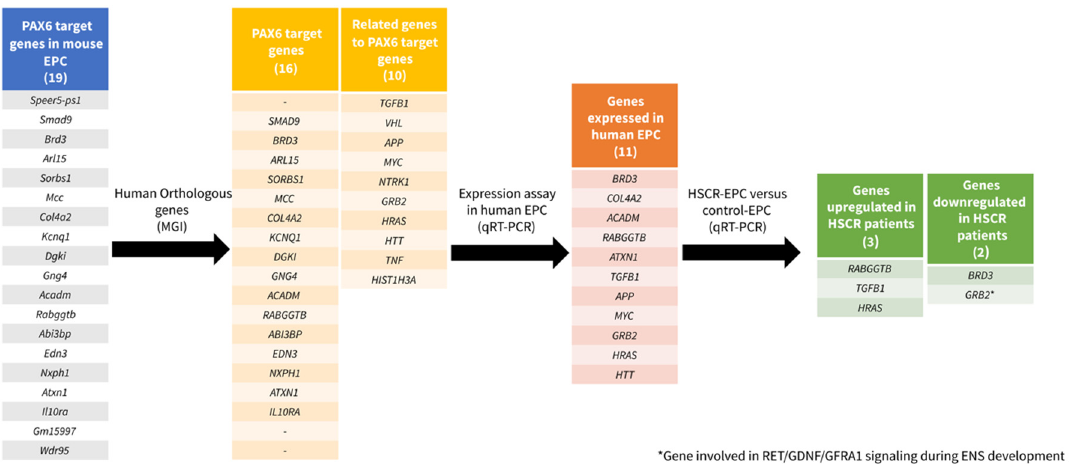
Figure 3. Diagram that shows the workflow with the selection, prioritization, and further validation of the candidate